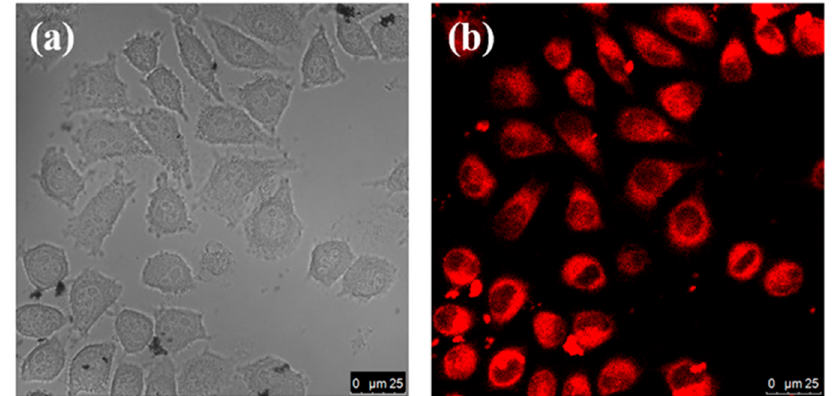
Figure 5. Confocal fluorescence microscopy images of HeLa cells incubated with PCDs under bright field ( a ) and the excitation wavelength of 552 nm ( b ).